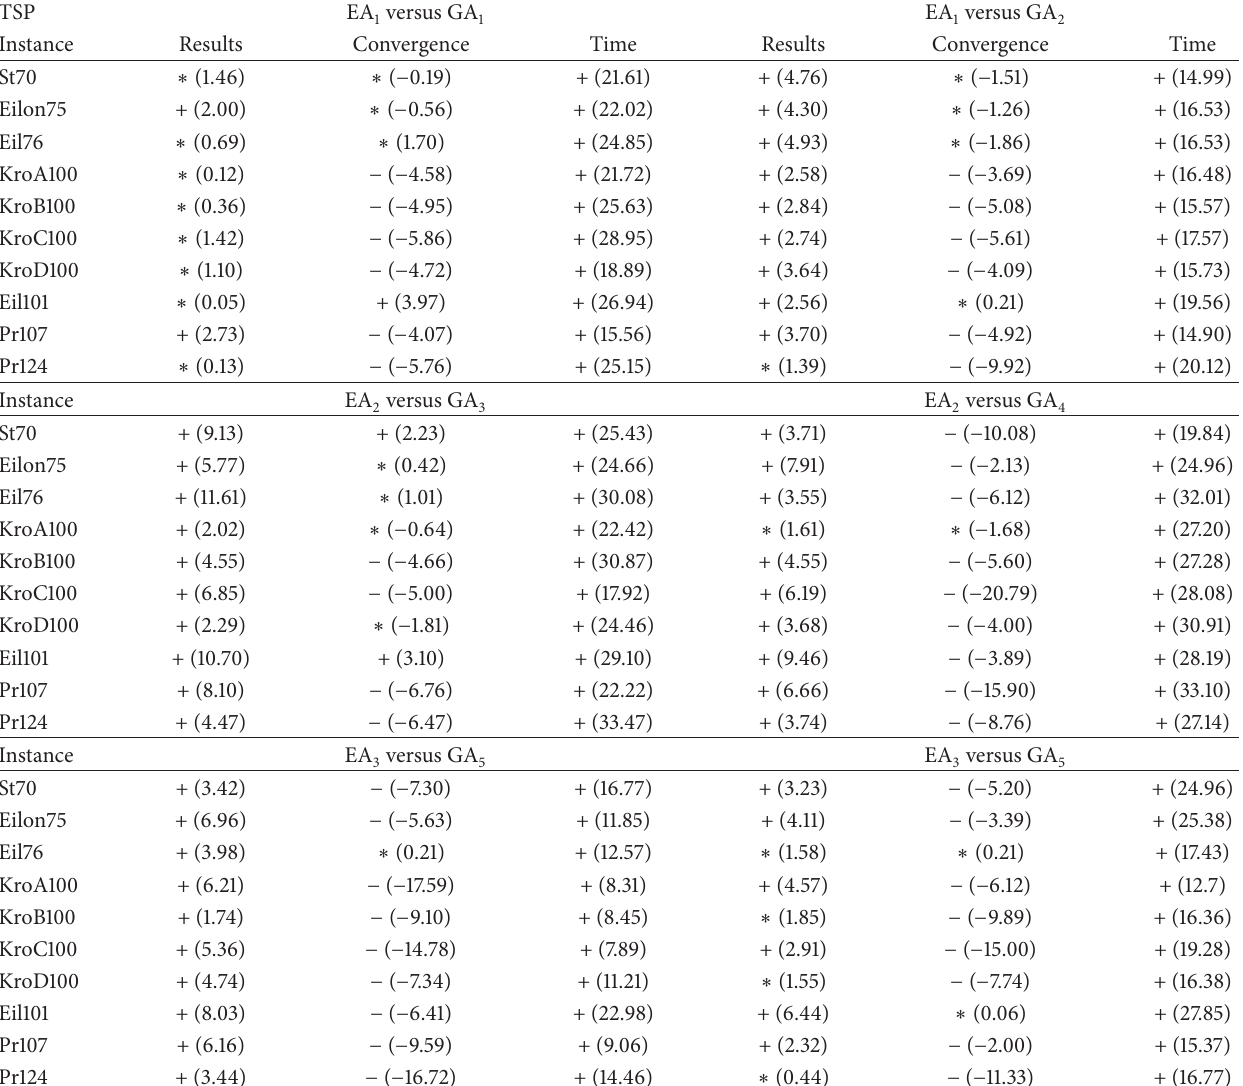
Table 4: 𝑧 -test for TSP. “+” indicates that EA is better. “ − ” depicts that it is worse. “ ∗ ” indicates that the difference between the two algorithms is not significant (at 95% confidence